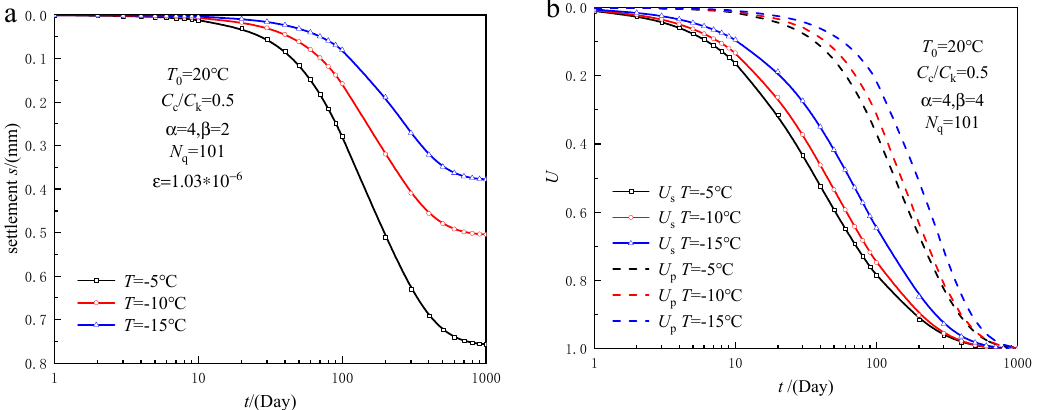
Figure 4. Influence of the temperature: ( a ) the distribution of the settlement, and ( b ) the distribution of the degree of the consolidation defined by settlement and excess pore water pressure.